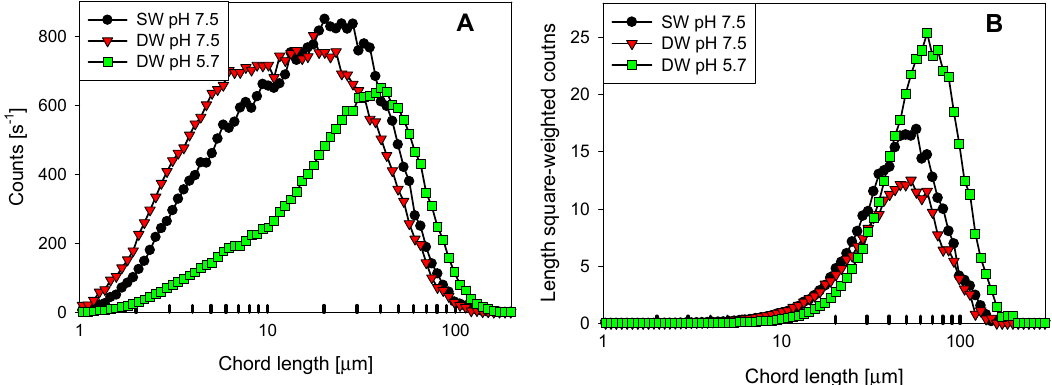
Figure 5. Chord length distribution (CLD) for untreated kaolin suspensions prepared at 7 wt. % in distilled water (pH 5.7 and pH 7.5) and seawater (pH 7.5). ( A ) Unweighted CLD, ( B ) Square-weighted CLD.